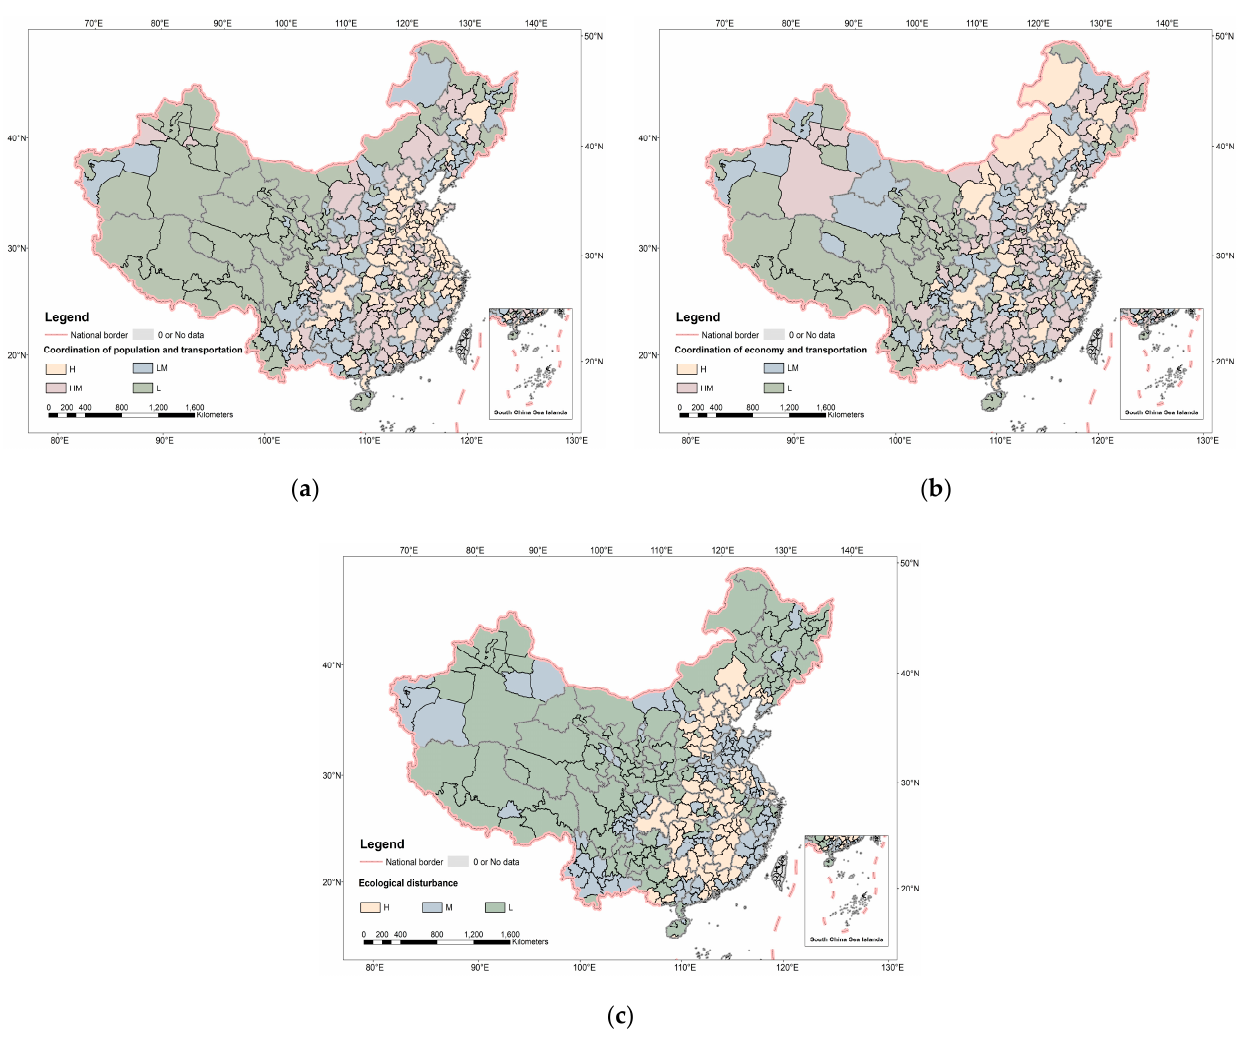
Figure 5. Coordination between population, economy, ecology and transportation. ( a ) Coordination of population and transportation; ( b ) coordination of economy and transportation; ( c ) ecological disturbance caused by transportation construction.